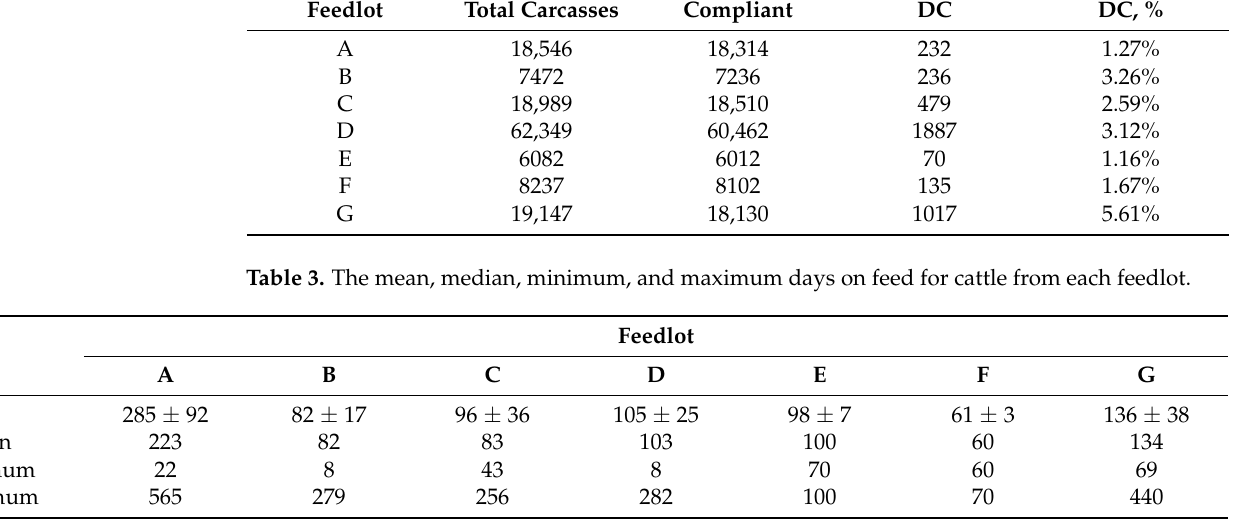
Table 2. The total number of carcasses, number of carcasses classified as compliant (pH ≤ 5.7) and non-compliant (pH > 5.70), and the percentage of non-complaint carcasses across the seven feedlots. Feedlot Total Carcasses